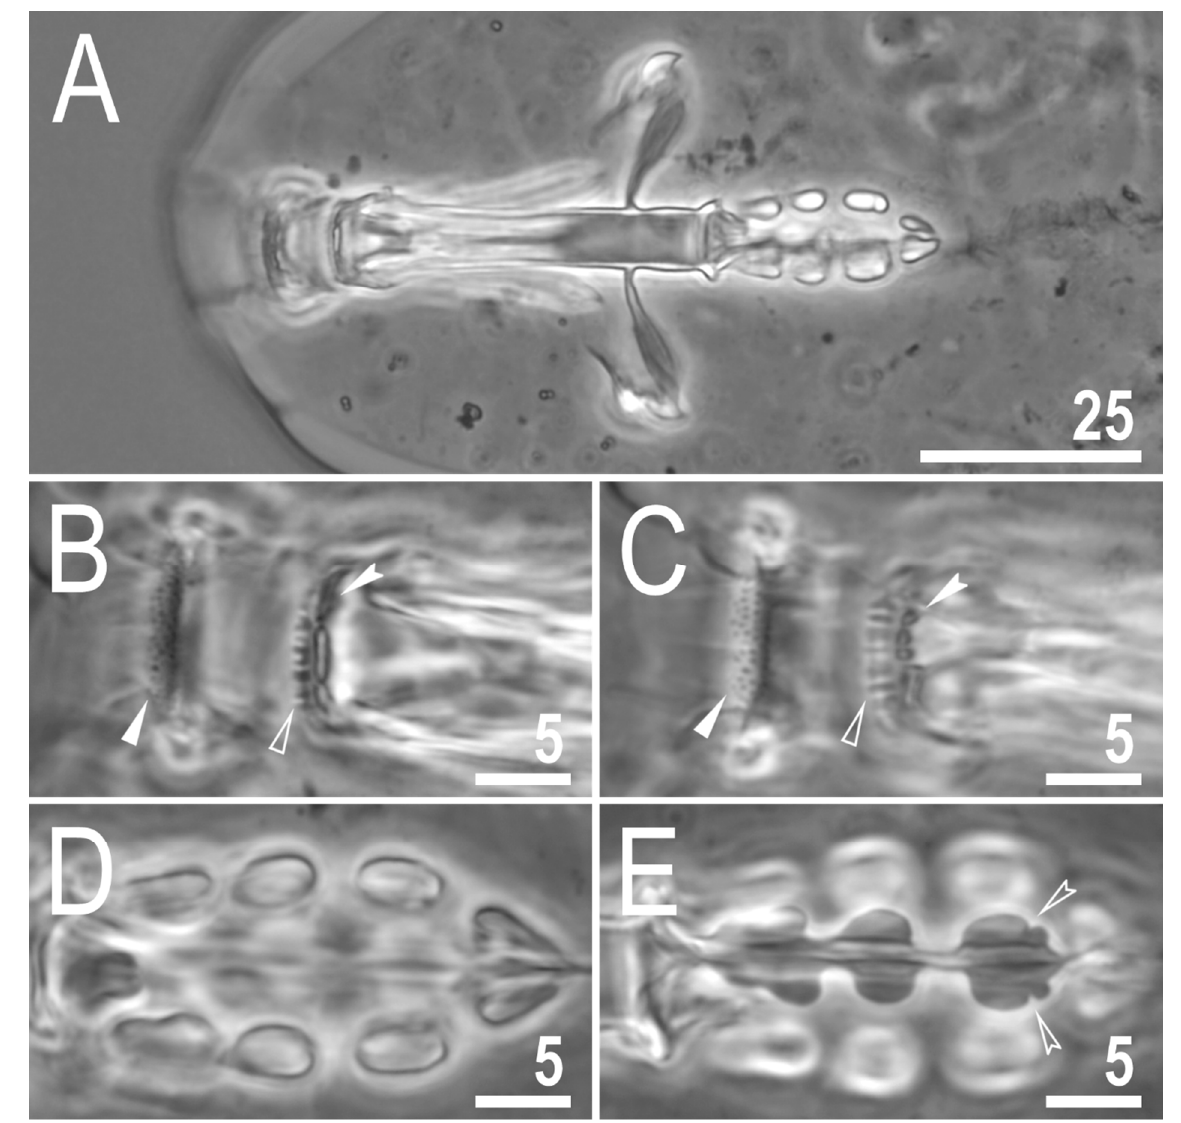
Figure 3. Mesobiotus imperialis sp. nov. —PCM images of the buccal apparatus: ( A )—an entire buccal apparatus (paratype); ( B , C )—the oral cavity armature, dorsal and ventral teeth, respectively (paratype); ( D , E )—placoid morphology, dorsal and ventral placoids, respectively (holotype). Filled flat arrowheads indicate the first band of teeth, empty flat arrowheads indicate the second band of teeth, filled indented arrowheads indicate the third band of teeth, empty indented arrowheads indicate subterminal constrictions in the third macroplacoid. Scale bars in μ m.